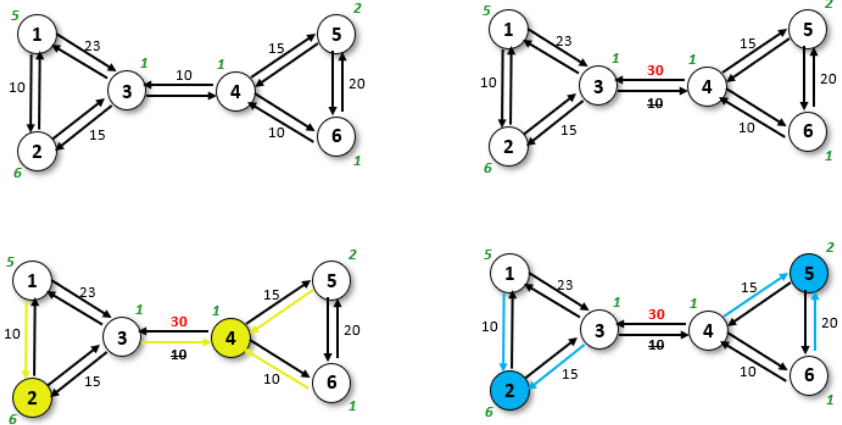
Figure 6. Impact of a detrimental event on the optimal centers’ deployments.